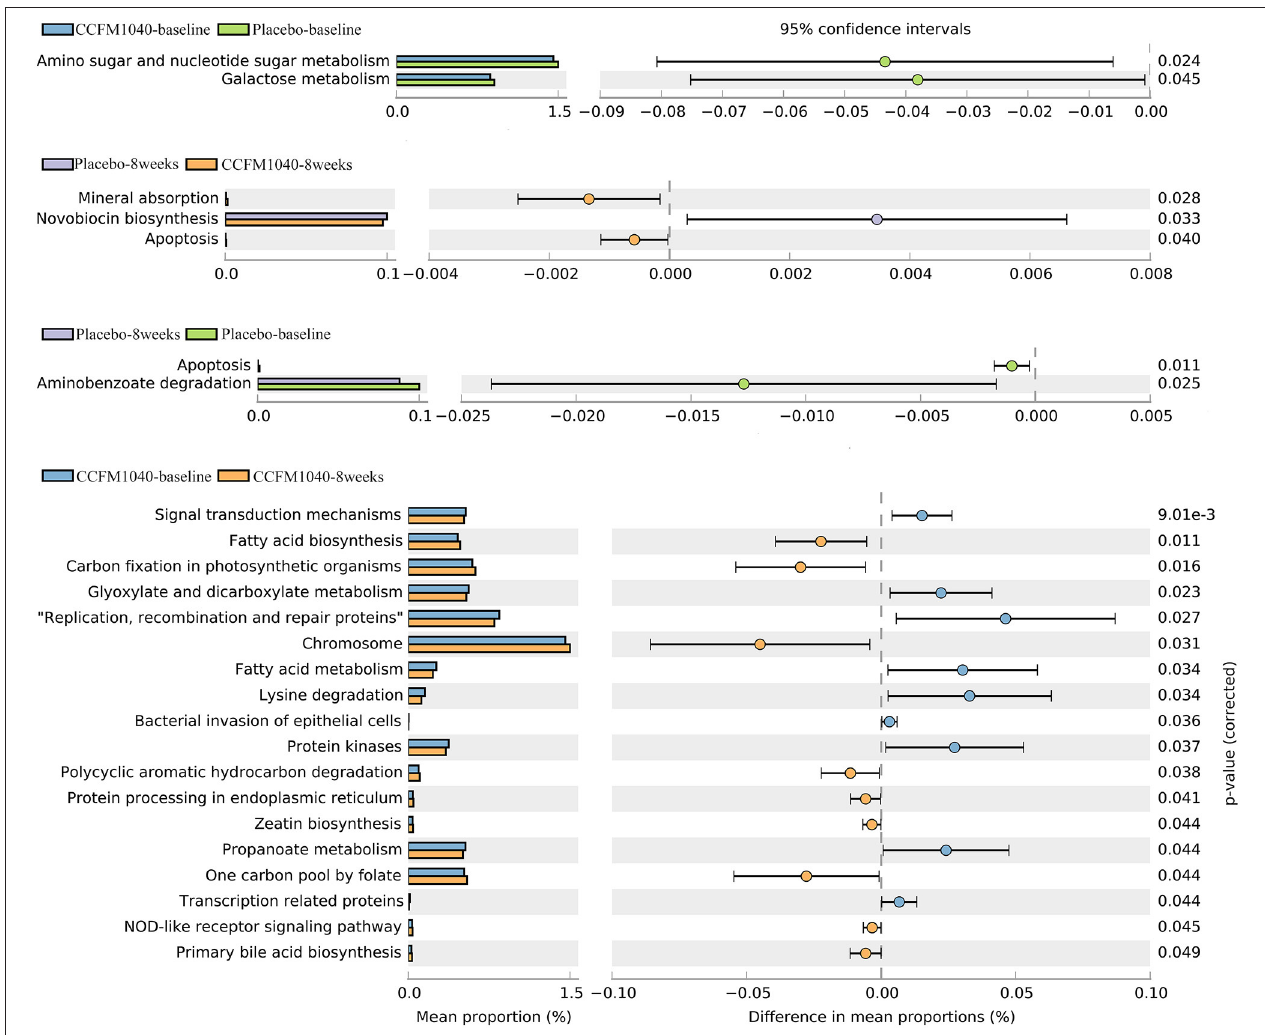
FIGURE 6 | Effect of CCFM1040 on the metabolism of the gut microbiota in patients with AR. P < 0.05. AR, allergic